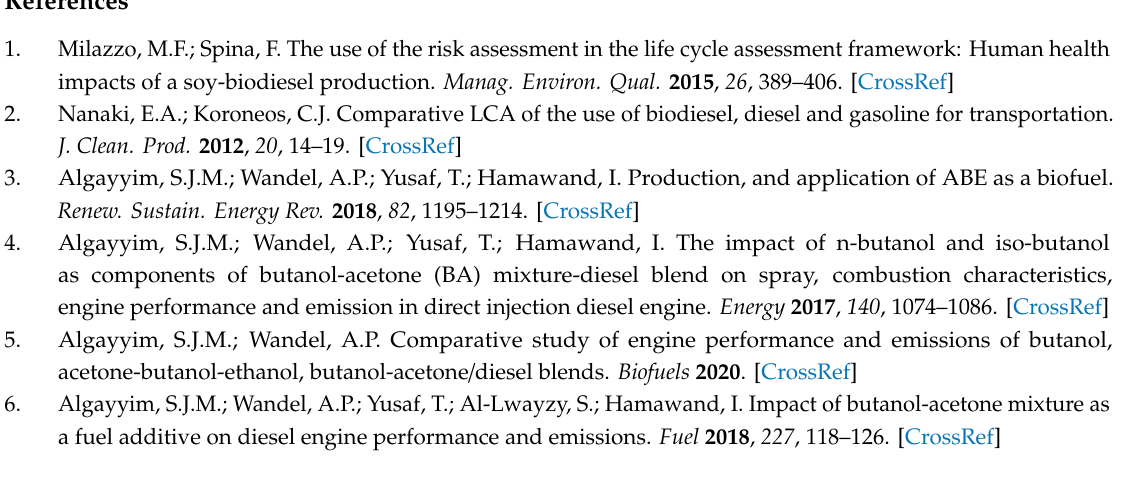
Figure 14. CO 2 emissions of test fuels.